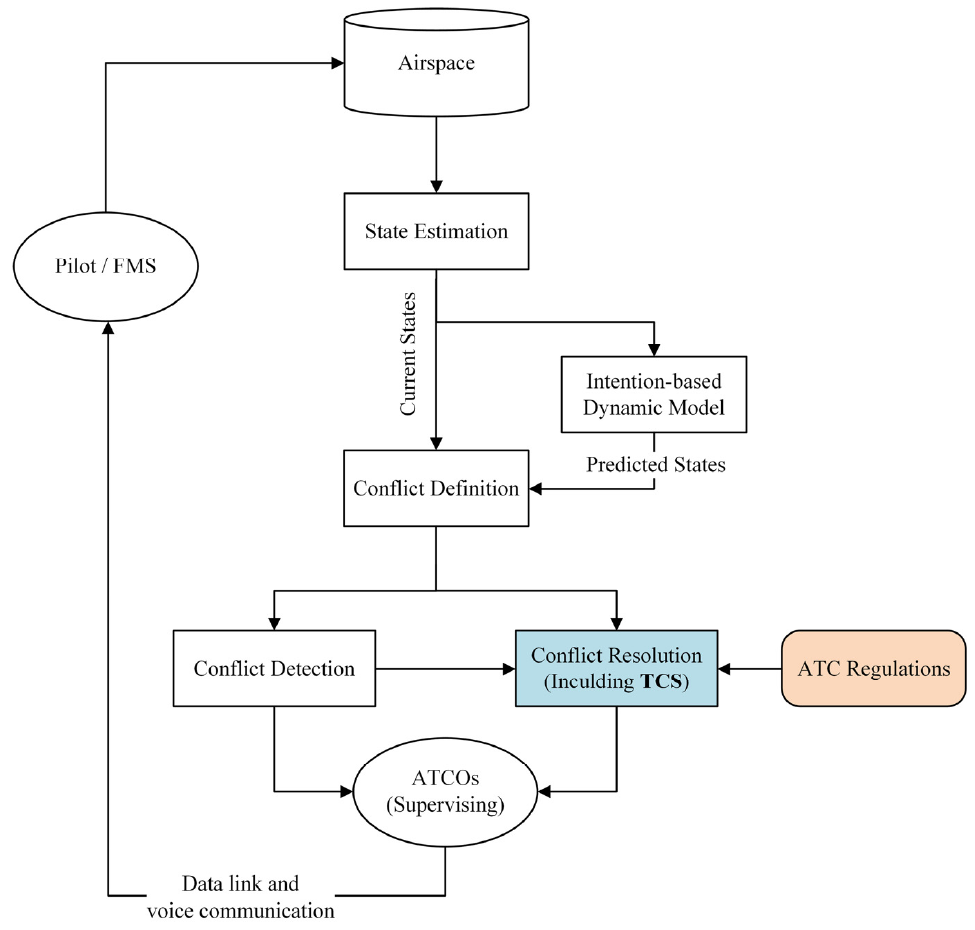
Figure 1. CD&R framework diagram.